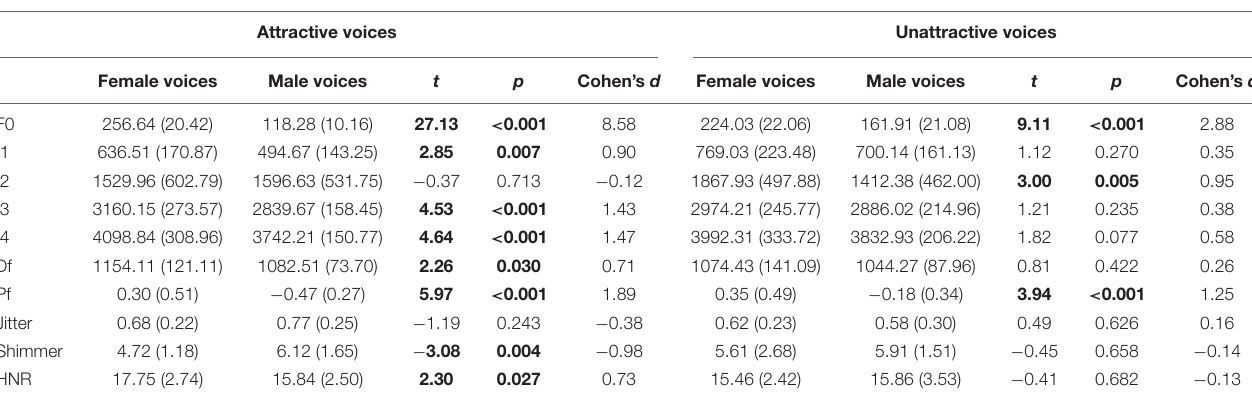
TABLE 3 | Acoustic differences between female and male